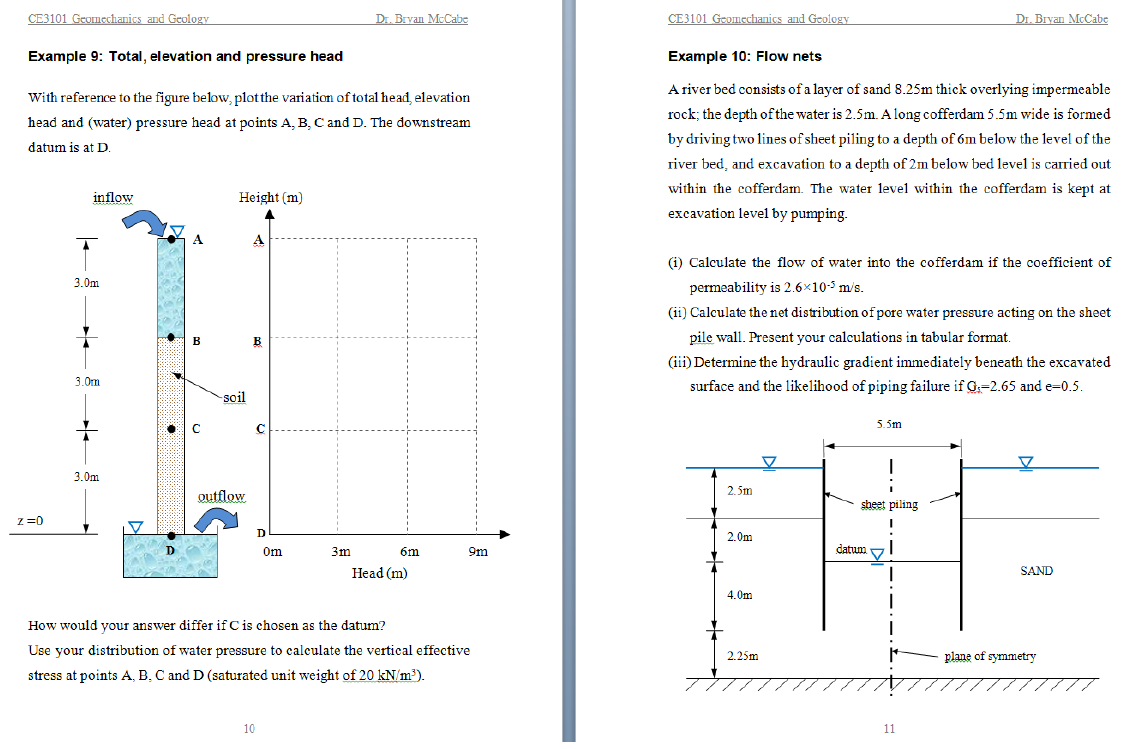
Figure 1: Sample workbook problems related to seepage in